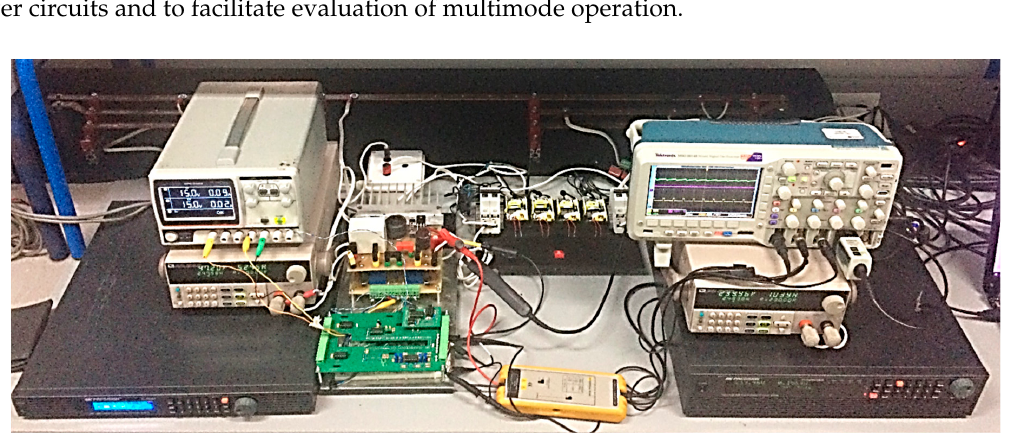
Figure 16. Schematic electrical diagram of the configured laboratory experiment. 5.1. Regulation of the LVDC Bus (Boost Mode) 5.1.1. Load Regulation Test In this test, sudden increasing and decreasing changes were applied to the load current 𝐼 (cid:2870) . The experiment started from an initial value of 50% in the nominal output power connected to the LVDC bus, which corresponded to 0.5 A. After 2 s, a decreasing step was introduced, leading the load to 20% of the nominal output power. Six seconds later, an increasing change of 20%–80% of the nominal power was introduced (i.e., from 0.2 to 0.8 A), the latter being a large-signal sudden change. It can be corroborated that the bus remained regulated and the control was robust to load disturbances. As shown in Figure 17, the system recovered the regulation of the bus around 0.5 s after the disturbance penetration, showing voltage deviations lower than 5% of the nominal LVDC voltage. 5.1.2. Line Regulation Test In this test, sudden changes were applied to the input voltage source representing the regulated ELVDC bus. The voltage started from its nominal value of 48 VDC, and 3 s later, its value decreased to 38 VDC. Three seconds later, the voltage of the source changed to 57 VDC. As shown in Figure 18, the system was able to reject input voltage disturbances rapidly, even when deviations were greater